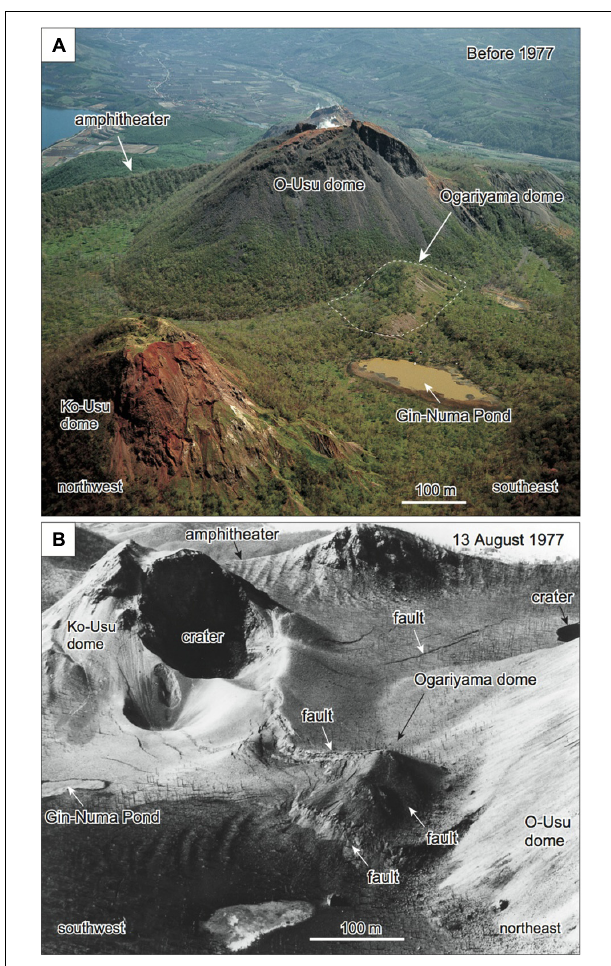
FIGURE 2 | (A) Aerial photograph of the Ogariyama dome, taken from the southwest before 1977. The photograph was provided by Toyako Town Office. (B) Aerial photograph of the Ogariyama dome taken from the southeast on 13 August 1977 (during the initial phase of the 1977–1978 eruption). Note that the Ogariyama dome is cut by several east–west-trending faults. The photograph (original black-and-white) was taken by Hokkaido Shinbun. The scale is approximate.